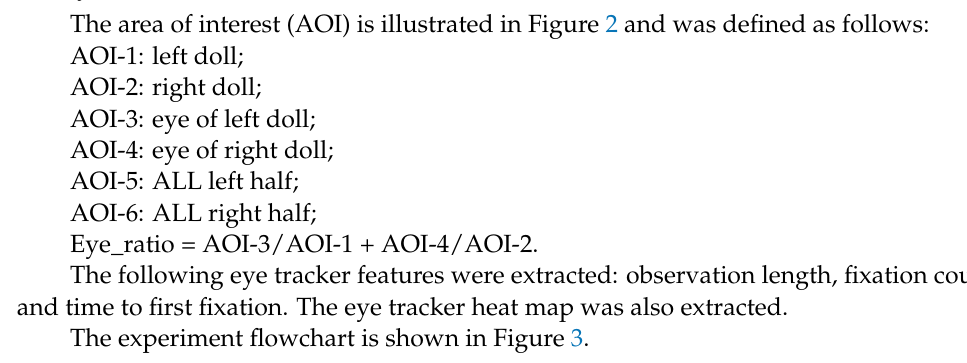
Figure 2. Eye tracker soothing dolls’ position and AOI.